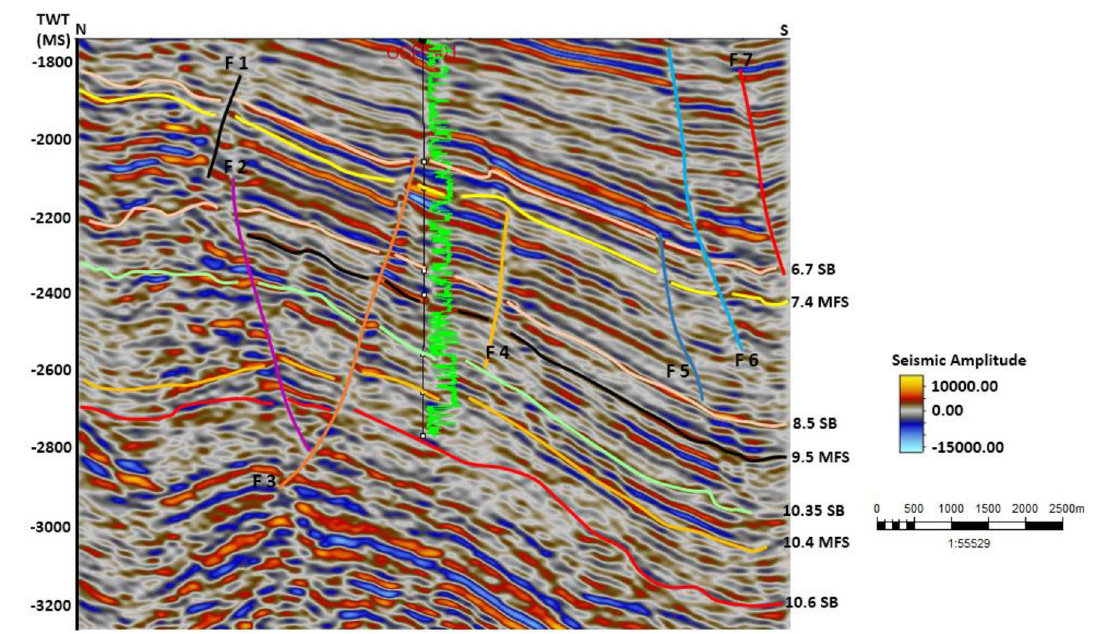
Fig. 13 Seismic section showing mapped faults and chronostratigraphic horizons (see Fig. 4 for